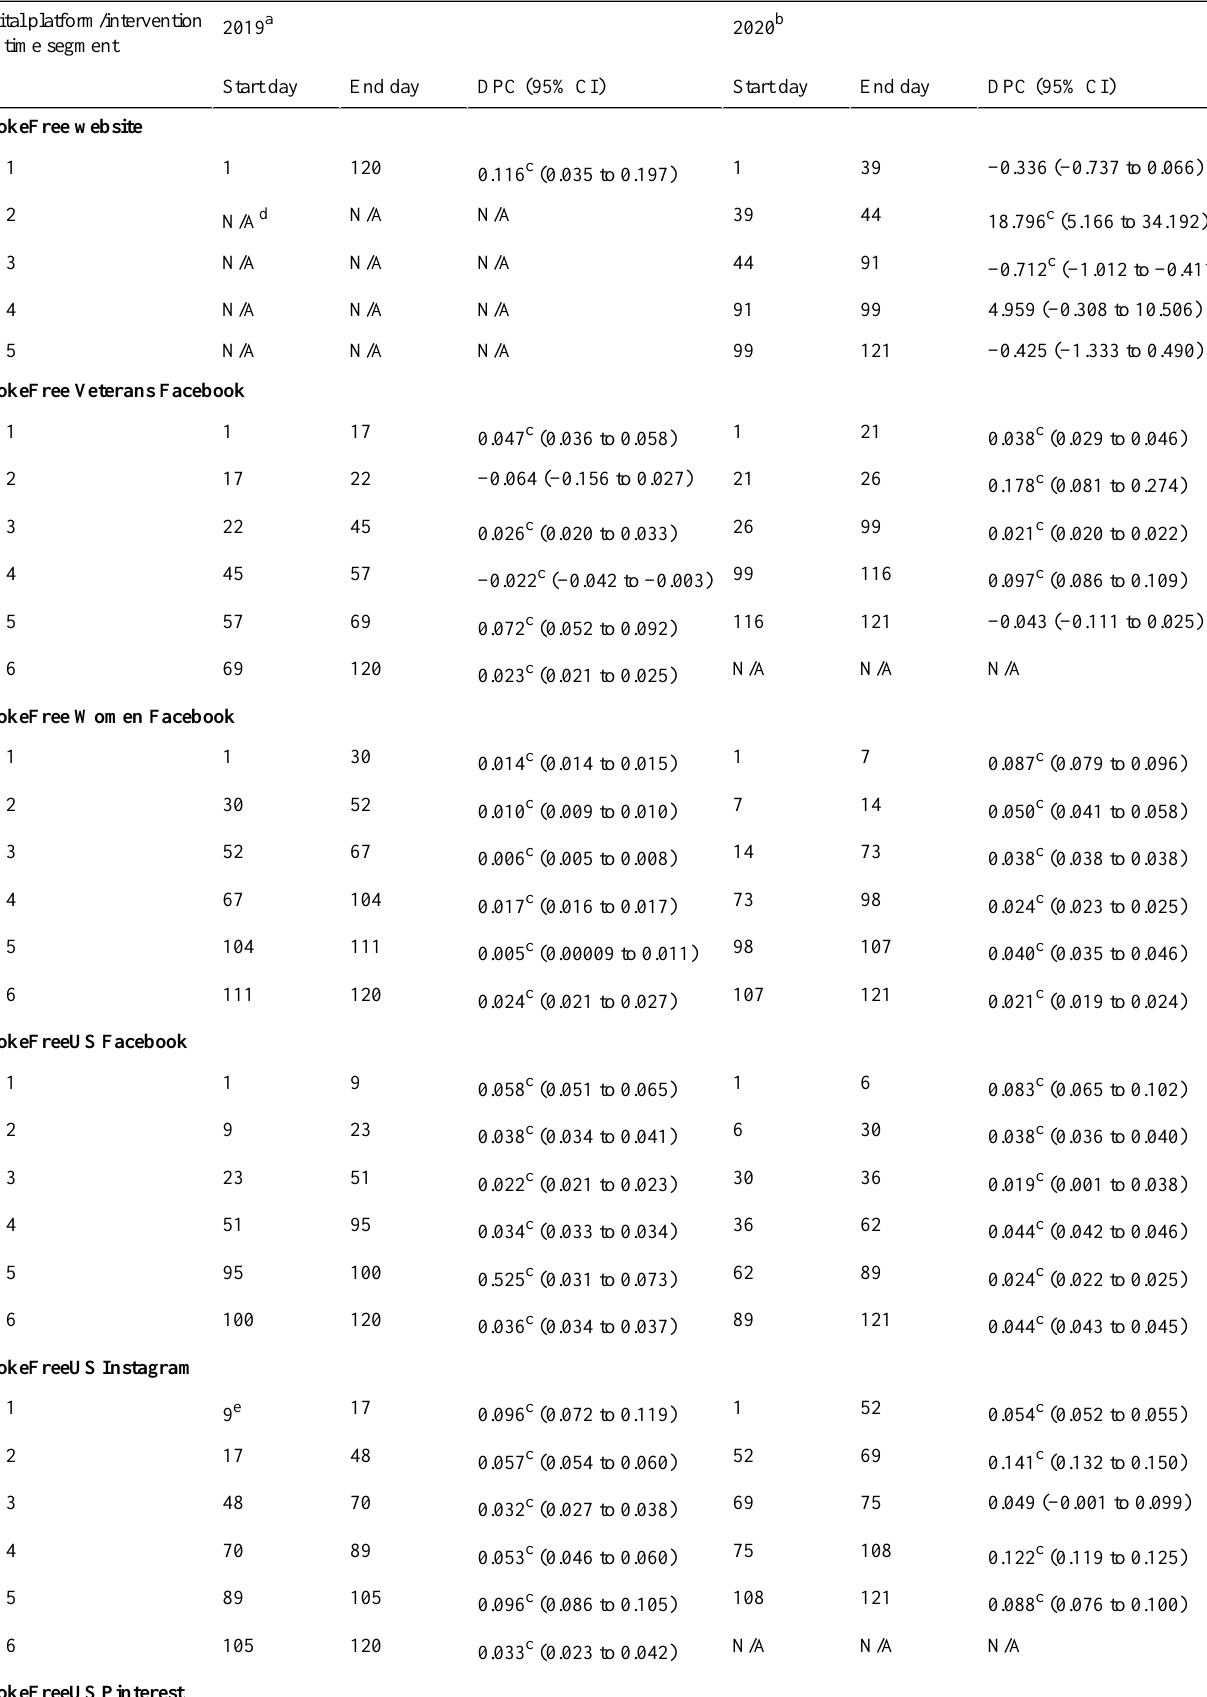
Table 1. Daily percent changes (DPCs) in the number of SmokeFree.gov initiative digital platform visitors, followers, and subscribers from January to April 2019 and